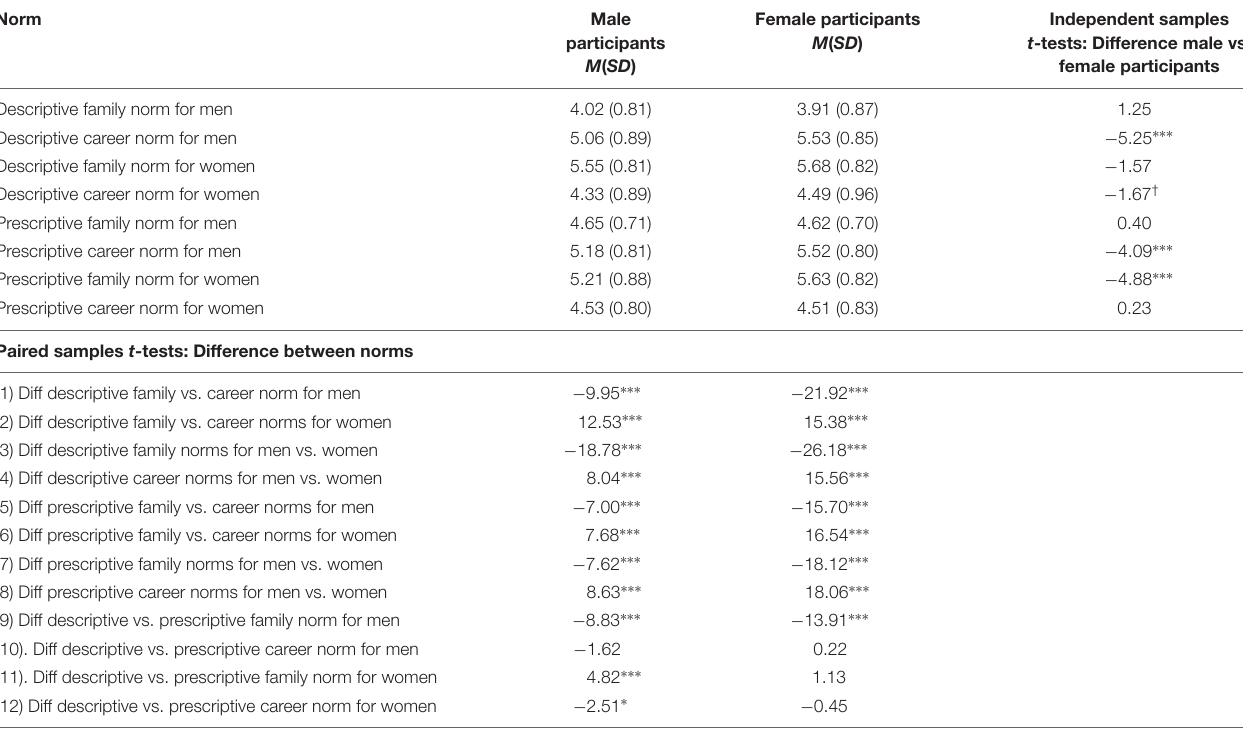
TABLE 2 | Difference tests investigating how descriptive and prescriptive norms about career and domestic investment differ from one another for men and women (bottom half of table), and in the perception of male and female participants (final column top half of table).